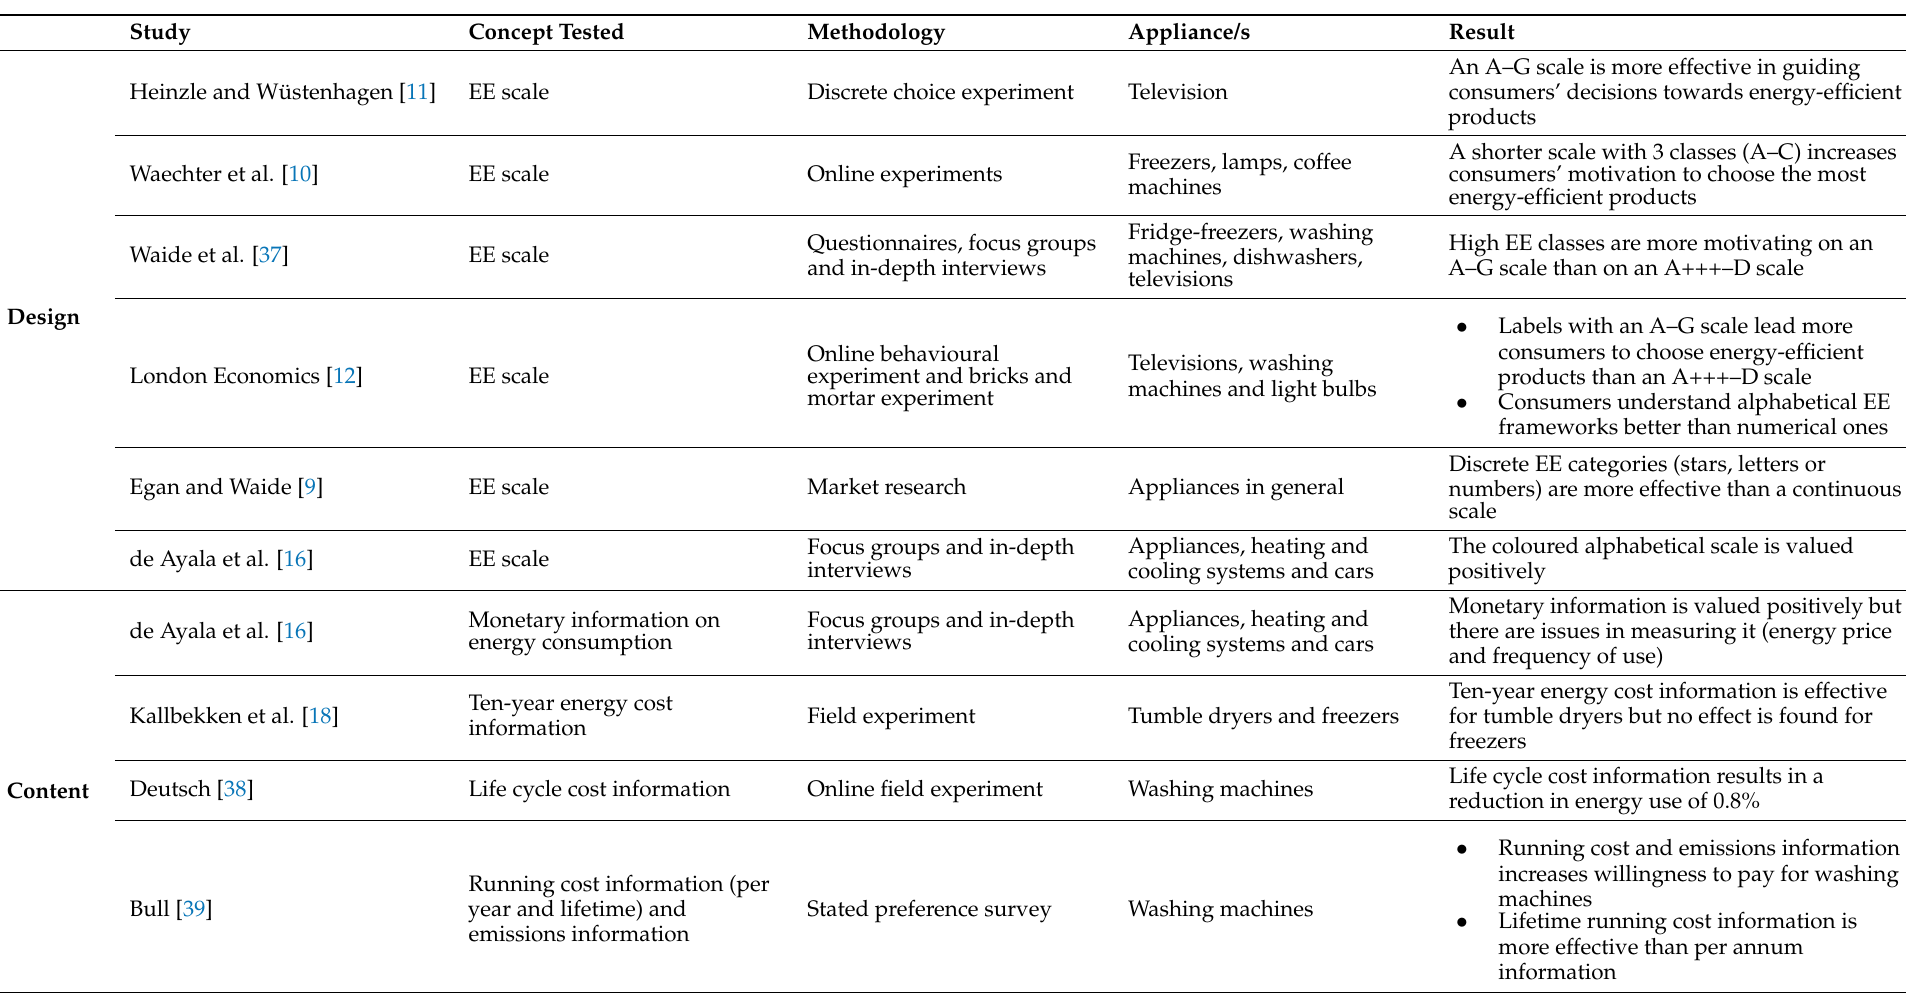
Table 1. Summary of studies assessing EU labels for